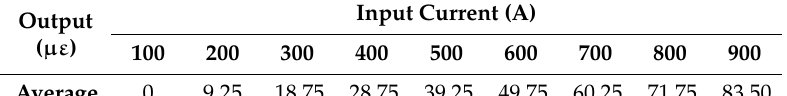
Table 4. Average output of every input current.